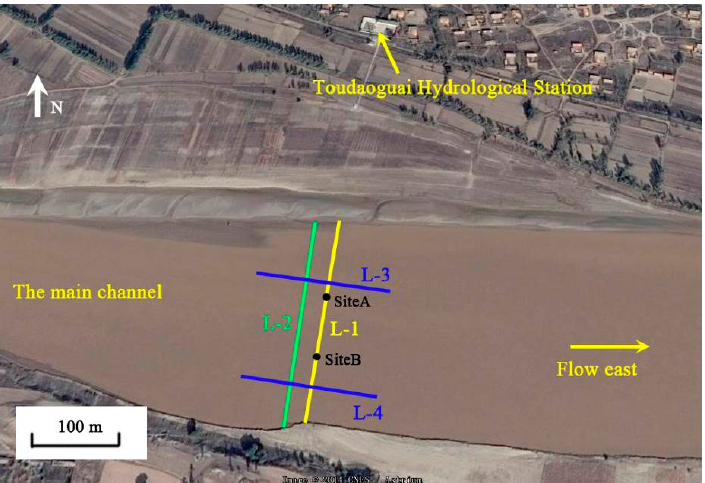
Figure 2. Aerial view of the Toudaoguai Hydrological Station section. Four survey lines (L-1, L-2, L-3, L-4) were used in the main channel during the field investigation. Site A and Site B are the locations of ice core sampling points respectively. Landscape image source: Google Earth, 25 October 2013.